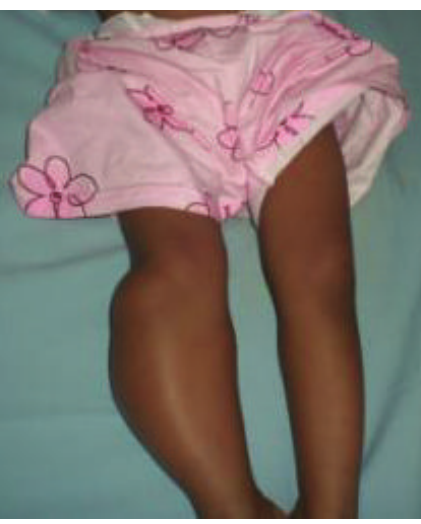
Figure 1: Clinical picture in Case 1 showed a big mass on the posterolateral side of right lower leg which had similar colour to the surrounding area.